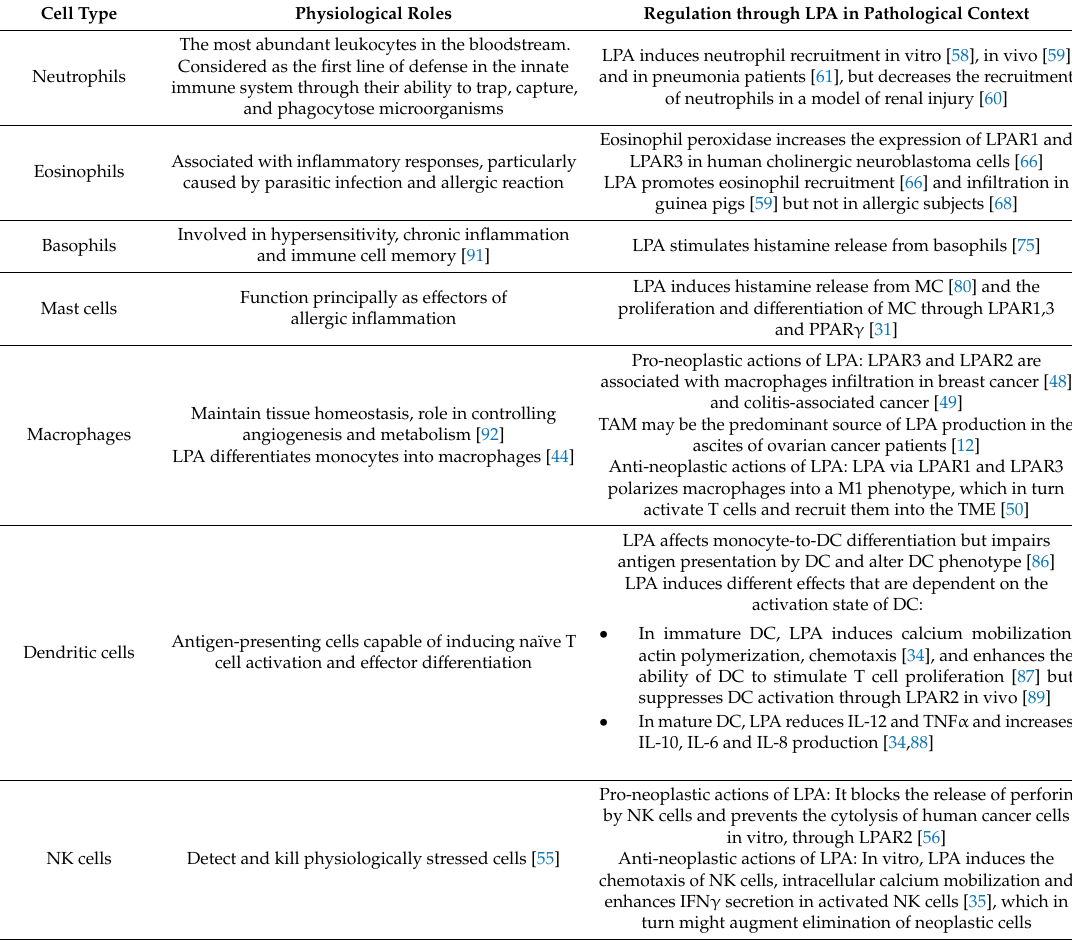
Table 1. E ff ects of lysophosphatidic acid (LPA) in Immune Cell Types of Innate